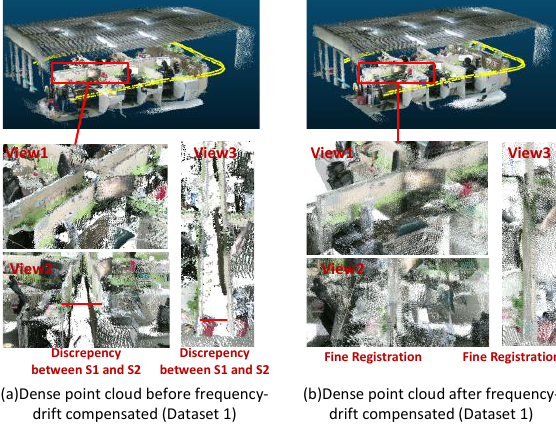
Figure 6. Comparison of the dense point cloud between before and after Fd-C of Dataset1